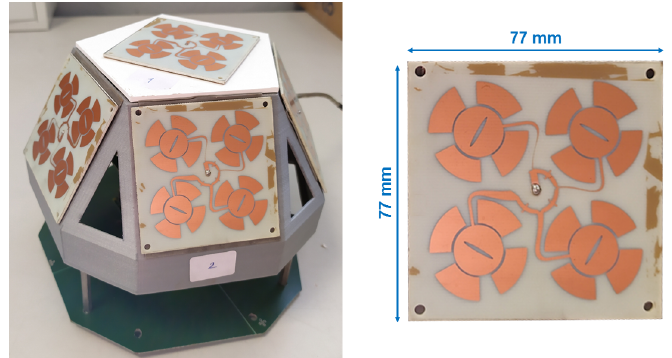
Figure 5. The assembled SBA of the anchor device adopted in the experiments ( left ), detail of the single array element ( right ).